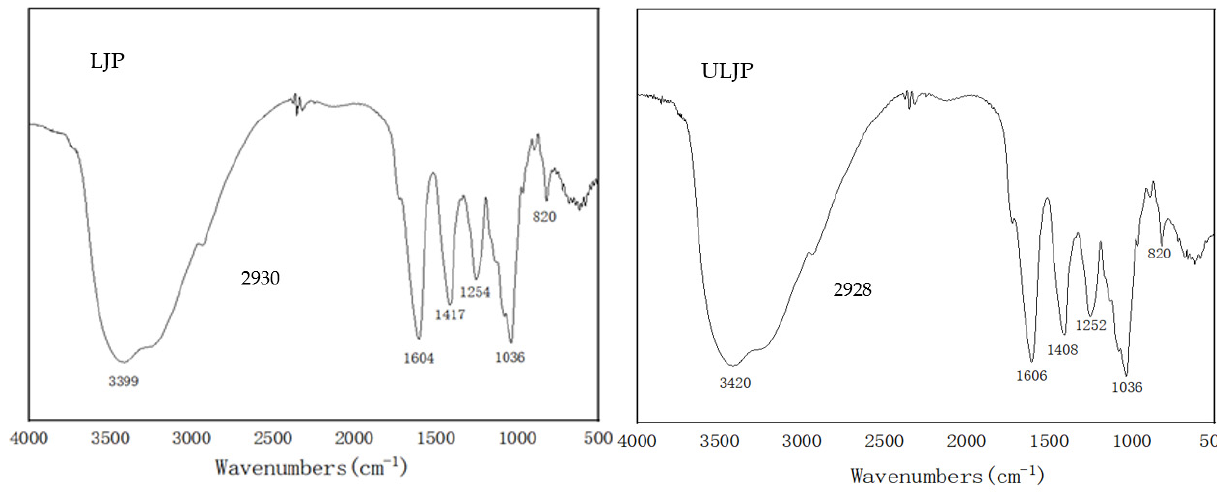
Figure 2. IR spectrum of LJP and